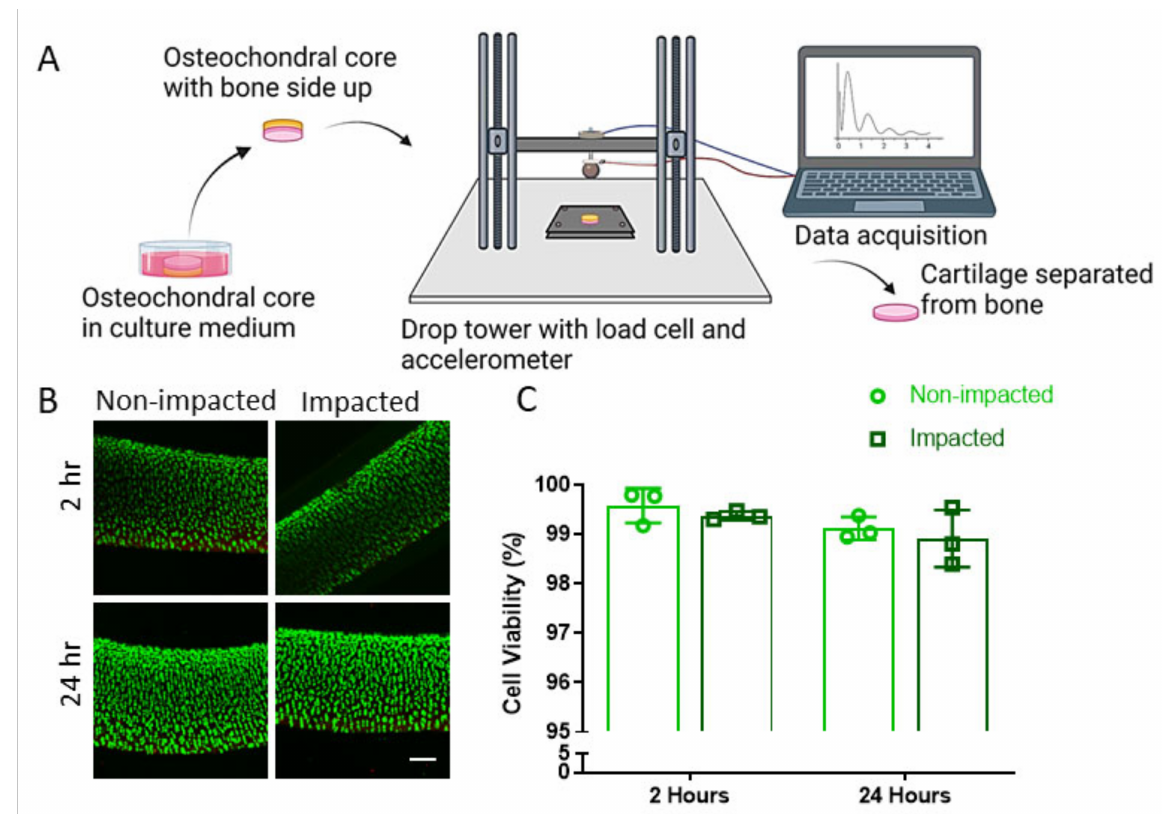
Figure 1. Sublethal cartilage impact is a platform to study acute molecular events in the chondrocyte injury response. ( A ) Schematic of drop tower, impact methods, data acquisition, and post impact tissue processing. ( B ) Live (green) and dead (red) staining of non-impacted and impacted cartilage via confocal microscopy 2 and 24 h post impact. Scale bar = 200 µ m. ( C ) Quantification of chondrocyte viability. No significant differences were detected between groups ( n =